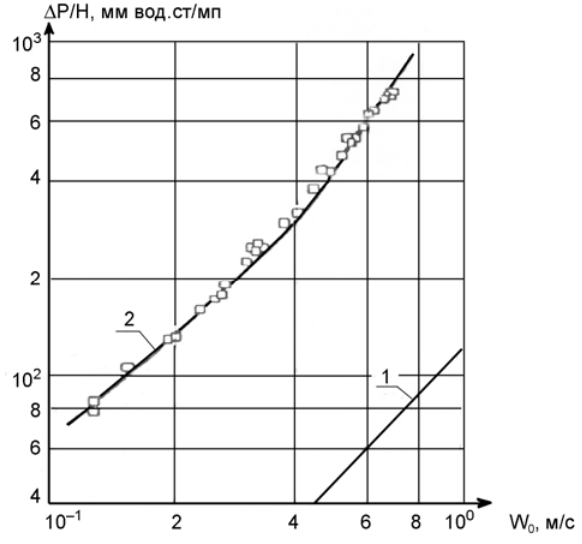
Рис. 8. Сравнение опытных данных по гидравличе- скому сопротивлению насадки из ВПЯМ с зернистым слоем из угля марки СКТ-2 по данным работы Fig 8. Comparison of experimental data on hydraulic resistance of sedimentation from high porosity material with granular layer from coal (mark SKT-2) according to this work (Пушнов 1987): 1 – VPIAM, d e = 1,5 mm; 2 –